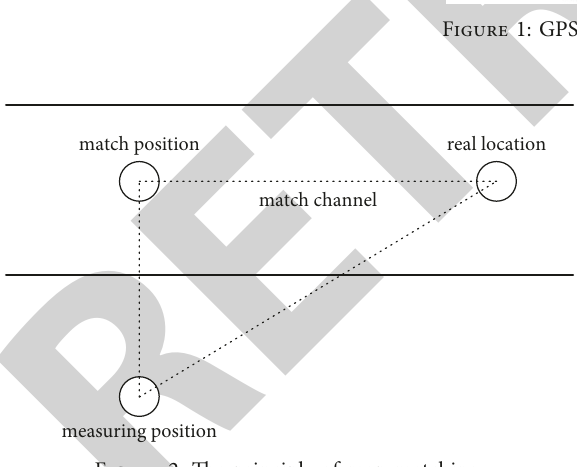
Figure 1: GPS positioning principle.